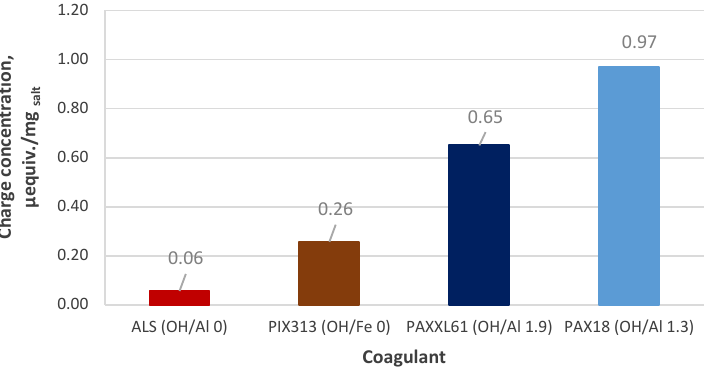
Figure 10. Charge concentrations of the studied coagulants.